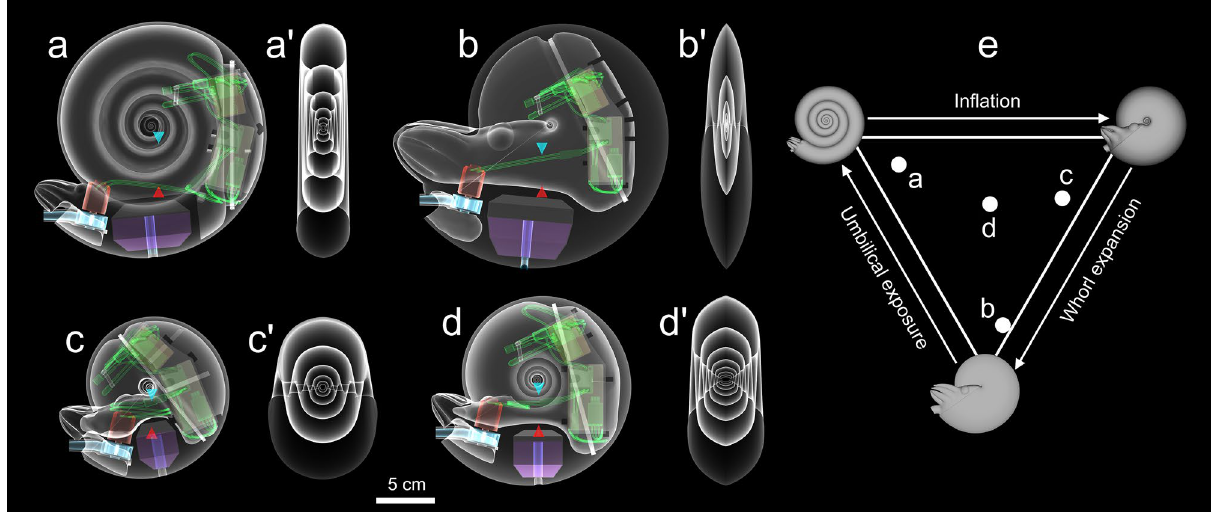
Figure 2. Transparent views of assembled biomimetic robots. ( a ) Serpenticone, ( b ) oxycone, ( c ) sphaerocone, and ( d ) morphospace center. Prime symbols ( ′ ) refer to transparent, transverse views of each robot’s external shape. All colors correspond to components on Fig. 1. The tips of the blue (upper) and red (lower) cones denote the centers of buoyancy and mass, respectively. Note that the separations of these hydrostatic centers are much larger than those reported in Table S3, creating artificially high stability to isolate the variable of conch shape and to minimize rocking. ( e ) Locations of each examined morphology on the Westermann morphospace 22 . The corners of this ternary diagram represent high whorl expansion (oxycone), high umbilical exposure (serpenticone), and high conch inflation (sphaerocone). All models were rendered in MeshLab 76 .